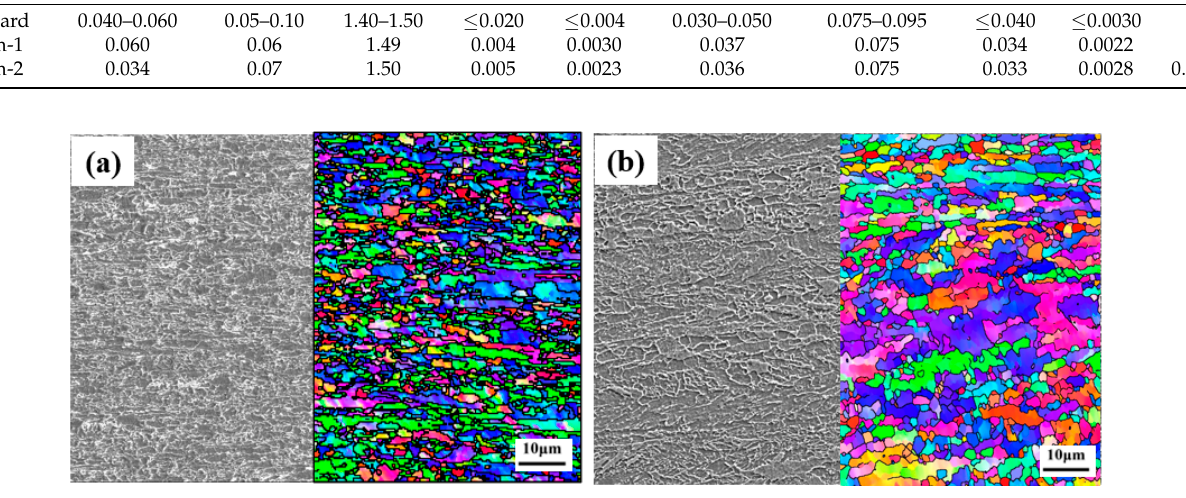
Figure 1. Microstructure of Beam-1 steel ( a ) and Beam-2 steel ( b ).